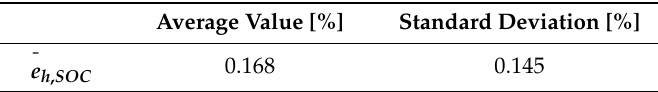
Table 11. Average hourly SOC estimation